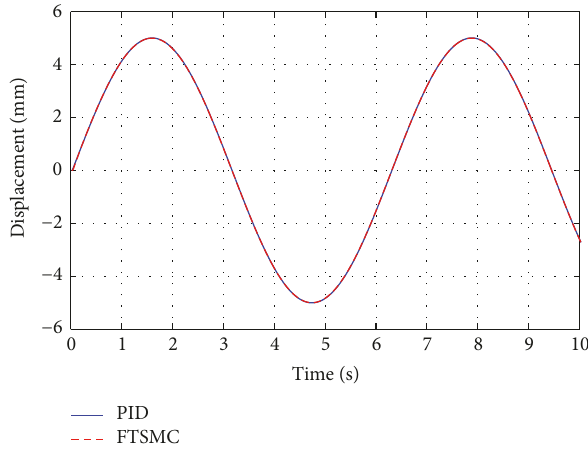
Figure 2: The response curves for displacement under step re- sponse.